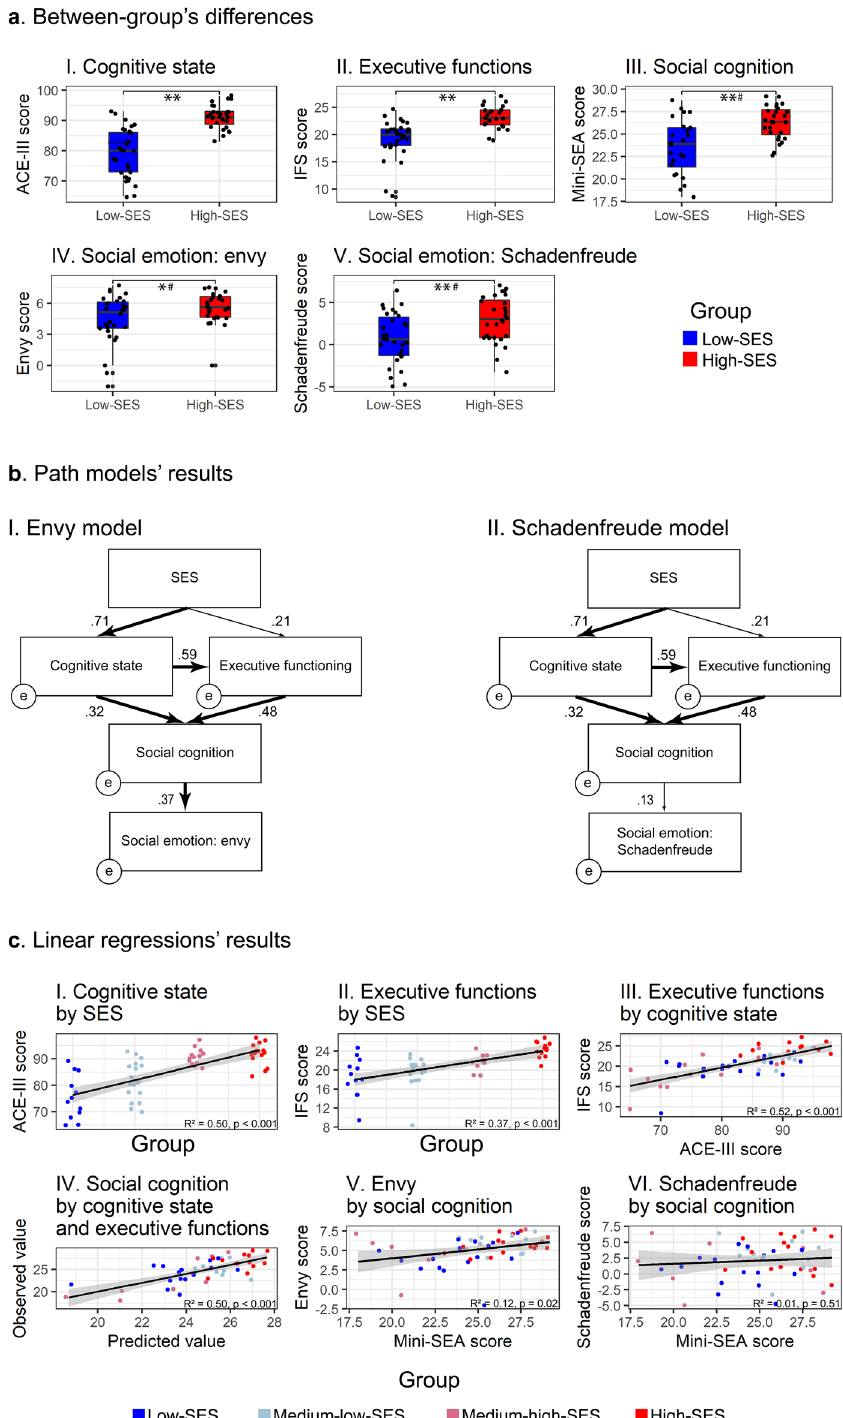
Figure 1. Results. ( a ) Data distribution and performance differences between low- and high-SES groups on cognitive state ( I ), executive functions ( II ), social cognition ( III ), and social emotions; envy ( IV ) and Schadenfreude ( V ). Boxplots display the median, interquartile range, and range of each variable. * p < 0.05, ** p < 0.001, # p > 0.05 after controlling for intervening variables (see “Methods” section). ( b ) Path analysis models and standardized path coefficients weights for envy ( I ) and Schadenfreude ( II ) as outcome social emotions. Bold arrows depict statistically significant paths. ( c ) SES predicts cognitive state ( I ) and executive functions ( II ). Cognitive state predicts executive functions ( III ). Cognitive state and executive functions predict social cognition ( IV ). Social cognition predicts envy ( V ) but not Schadenfreude ( VI ). All linear regressions’ results are statistically significant ( p < 0.05), except for ( VI ). ACE-III: Addenbrooke’s Cognitive Examination-III; IFS: INECO Frontal Screening; Mini-SEA: Mini-Social Cognition and Emotional Assessment; SES: socioeconomic